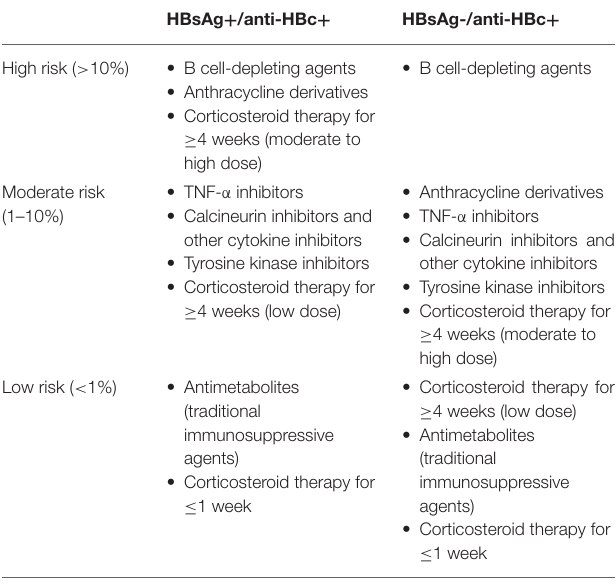
TABLE 2 | HBV reactivation risk according to serologic status of chronic hepatitis B and immunosuppressive agents. HBsAg + /anti-HBc